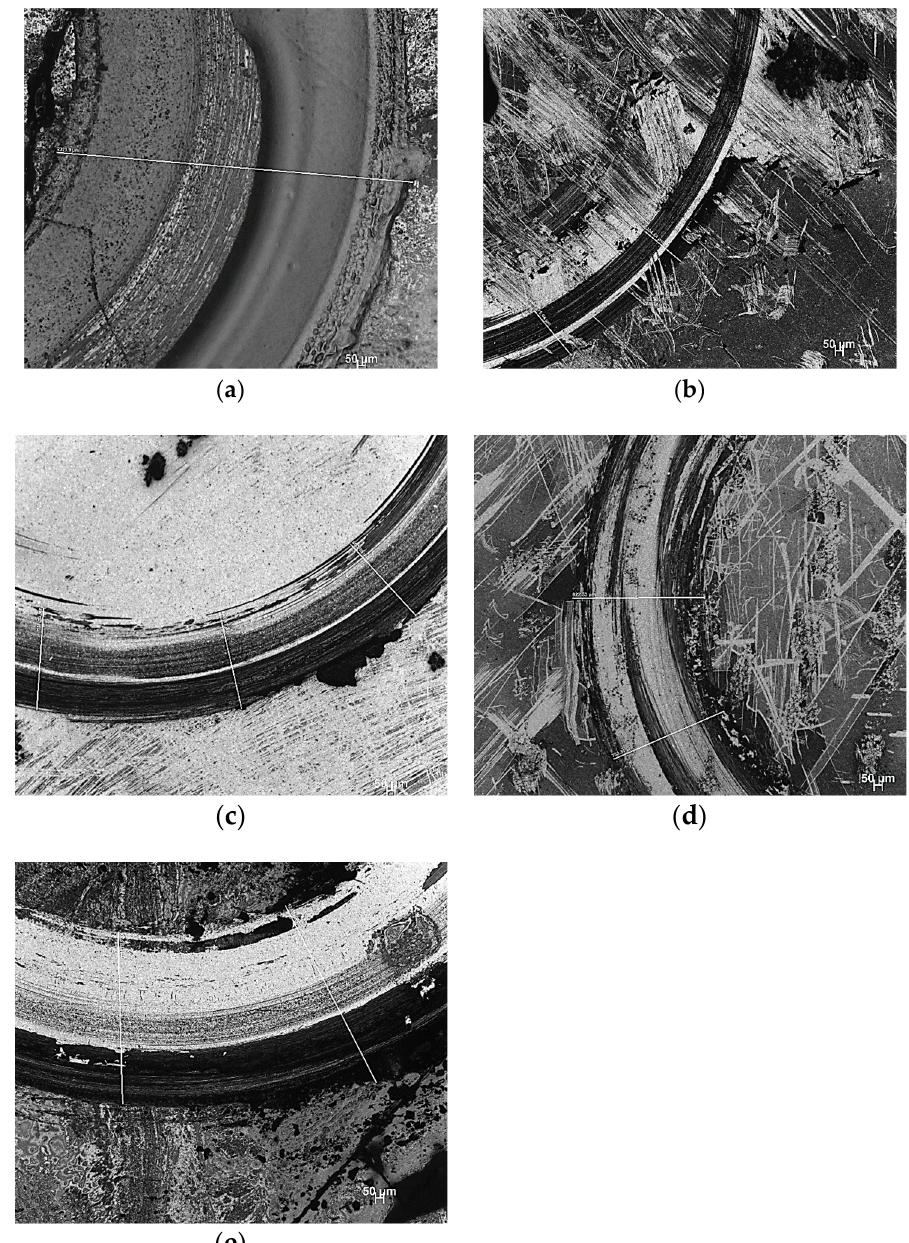
Figure 7. Optical microscope images of the wear tracks for ( a ) monolithic Al 2 O 3 , ( b ) Al 2 O 3 -15SiC, ( c ) Al 2 O 3 -20SiC, ( d ) Al 2 O 3 -25SiC, and ( e ) Al 2 O 3 -30SiC. Table 4. Approximate wear track sizes for the study’s composites.